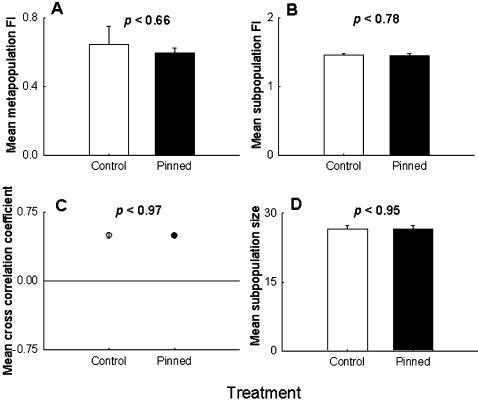
Experiment: effect of pinning at the metapopulation level, averaged over four replicate metapopulations. (A) Metapopulation stability and (B) subpopulation stability were measured as the fluctuation index (FI) over 21 generations. (C) Synchrony among nearest neighbors was measured as the cross-correlation at lag zero of the first differenced ln-transformed values of population sizes. Due to the high rates of migration, the subpopulations were found to be in synchrony, as demonstrated by the positive cross correlation coefficients. (D) Average subpopulation size. There was no difference among the pinned and the control metapopulations in any of the panels, indicating that pinning had no detectable effect on metapopulation dynamics.